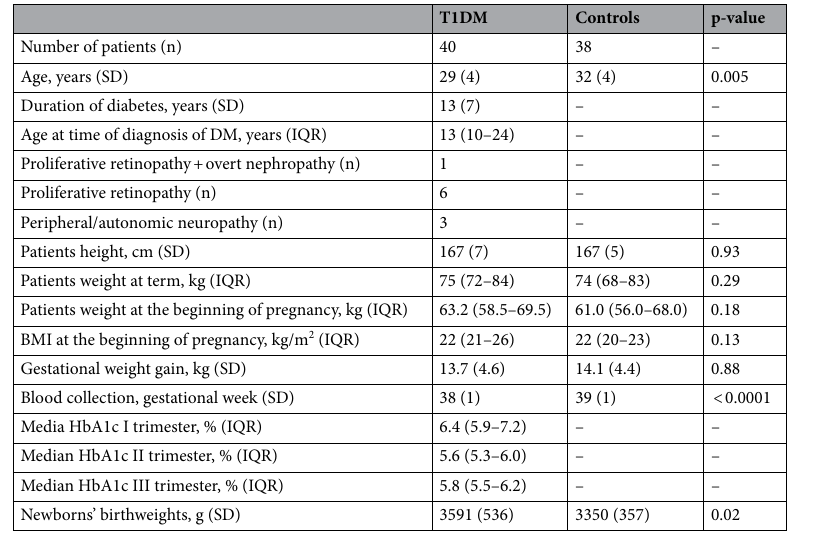
Table 1. Characteristics of the study